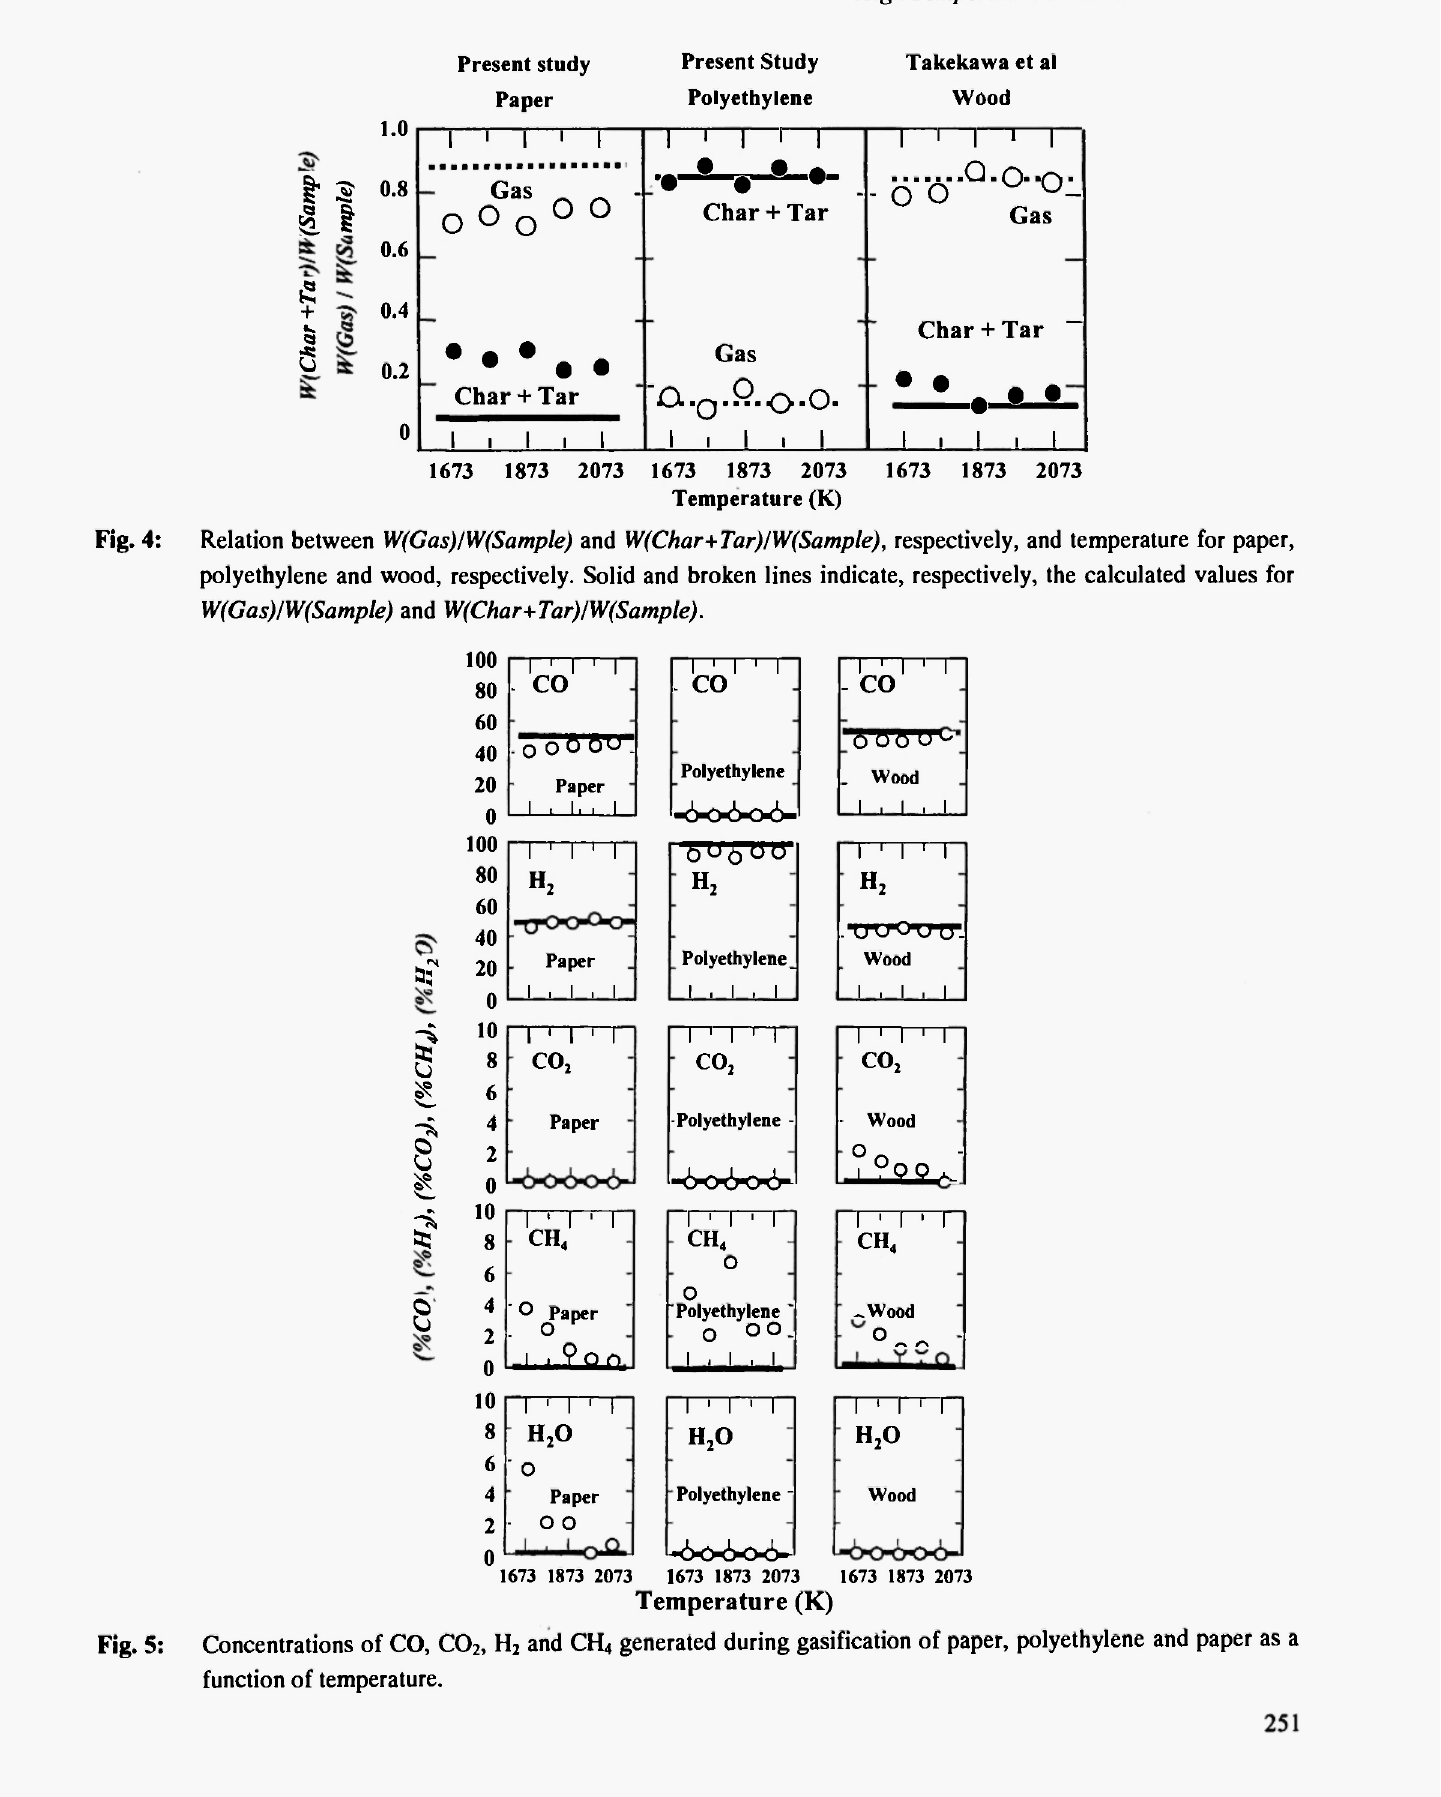
Fig. 5: Concentrations of CO, C0 2 , H 2 and CH 4 generated during gasification of paper, polyethylene and paper as a function of